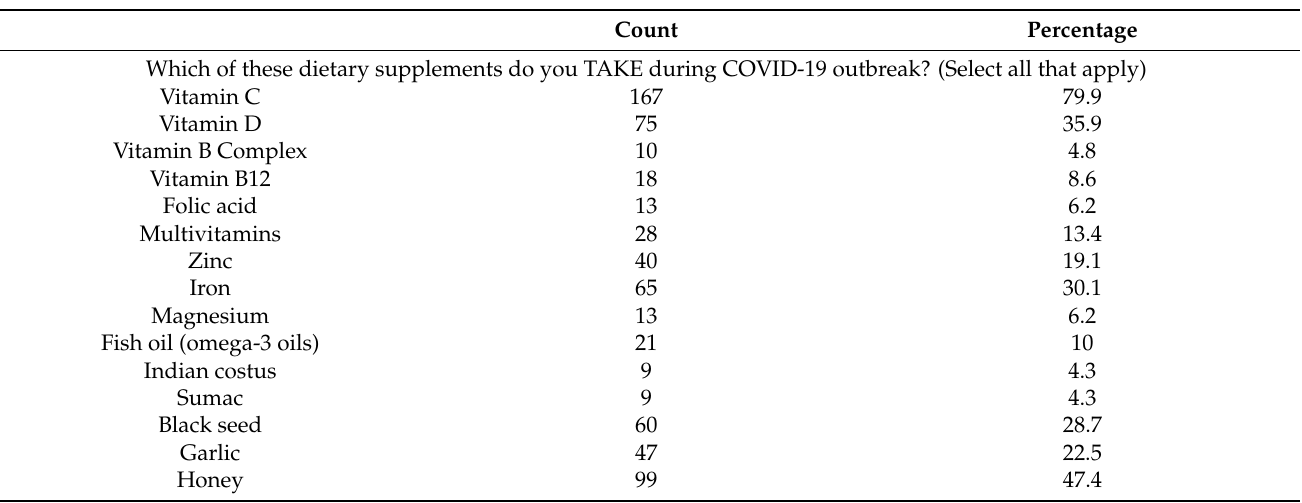
Table 7. The Dietary supplements.